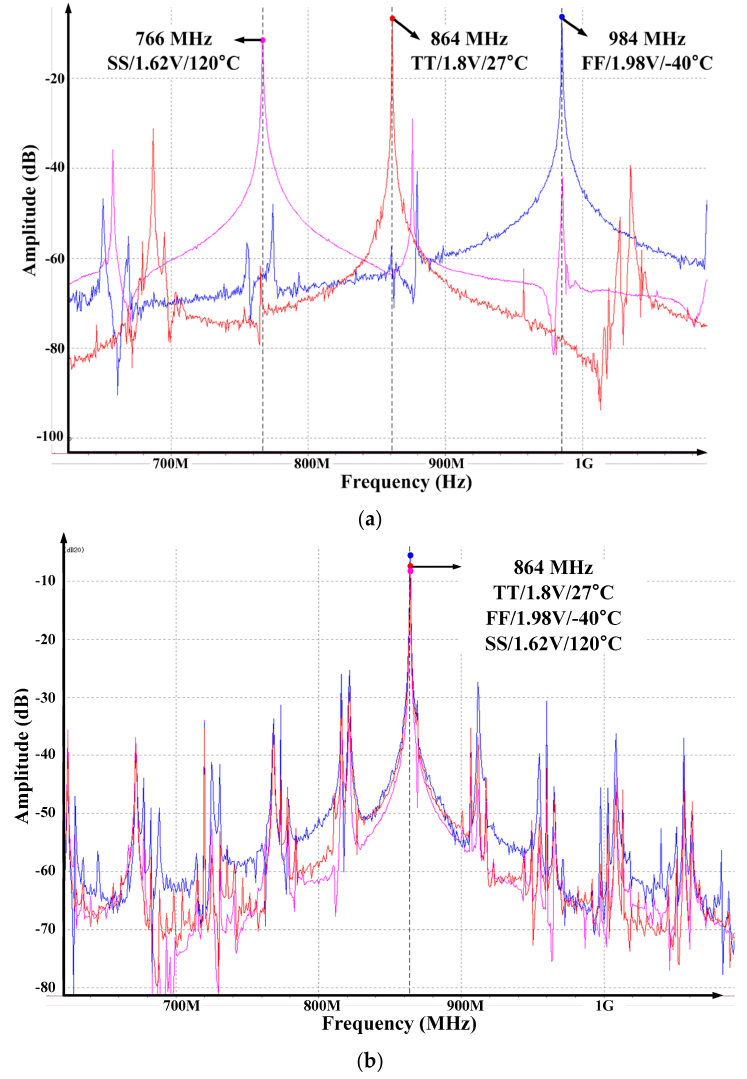
Figure 8. The simulation result of ILFM Frequency calibration ( a ) before calibration and ( b ) after